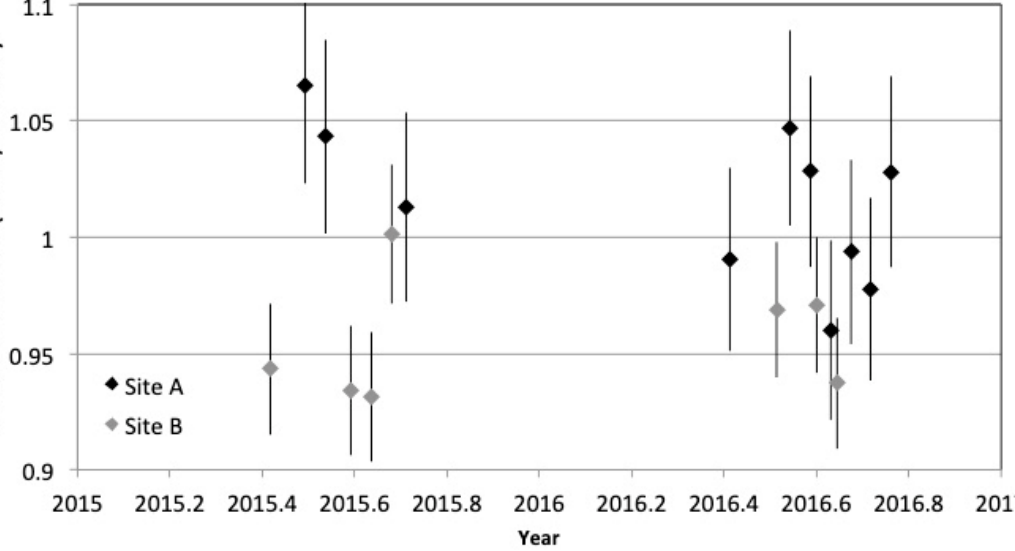
Figure 7. RadCalNet results from Sites A and B compared to Sensor #1 for similar dates. The error bars shown are the nominal absolute uncertainties for a single measurement reported by RadCalNet.